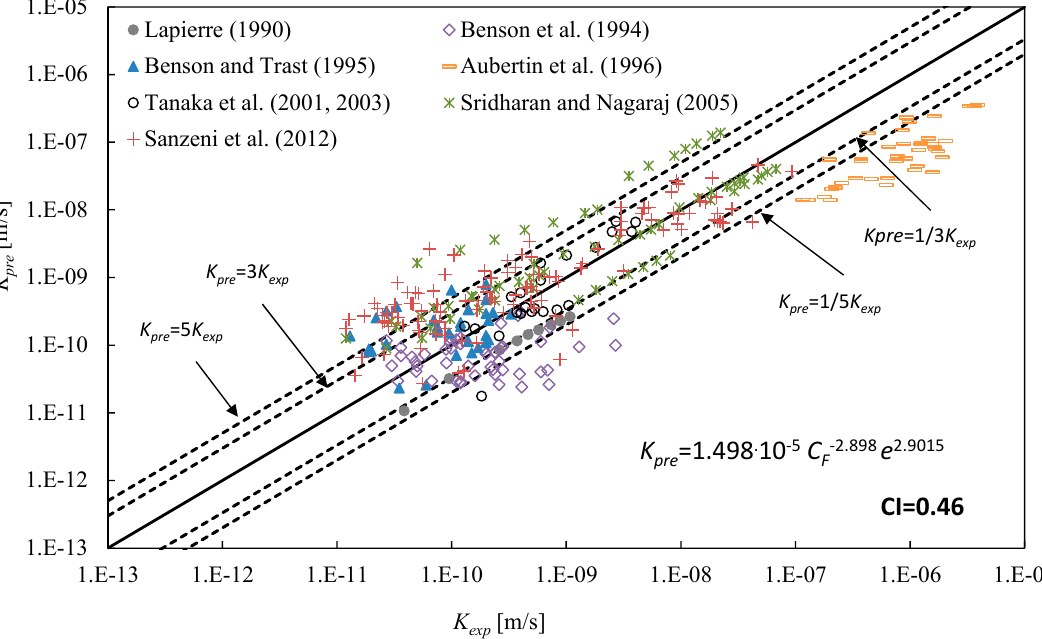
Figure 2. Experimental ( K exp ) and predicted value ( K pre ) of the saturated hydraulic conductivity as determined by Equation (19).